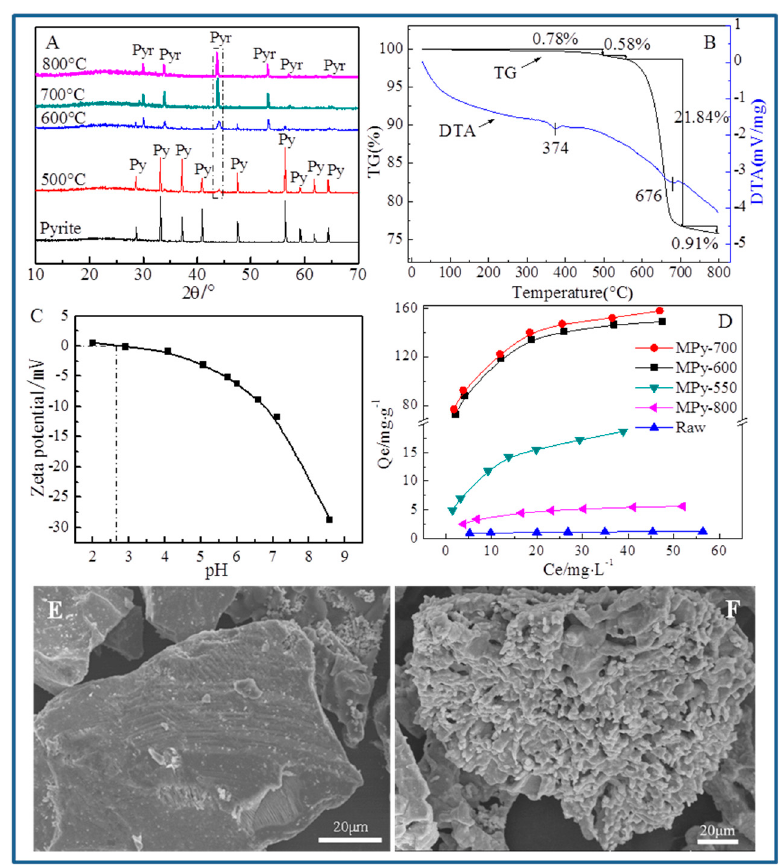
Figure 1. ( A ) XRD spectrum of natural pyrite and MPy. Py—pyrite; Pyr—pyrrhotite. ( B ) TG-DTA spectrum of natural pyrite in a N 2 atmosphere. ( C ) The zeta potential of MPy-600. ( D ) Removal isotherms of Hg(II) by pyrite and MPy. ( E , F ) SEM images of natural pyrite and MPy-600, respectively.